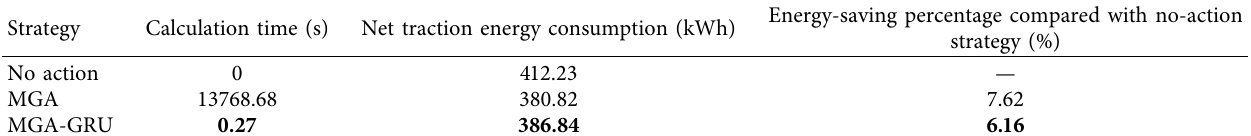
Table 8: Performances with three strategies in the three-train metro system.